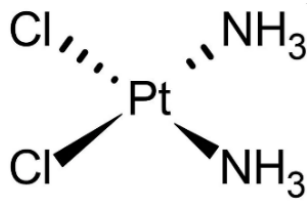
Figure 4. Cisplatin. Figure 4.